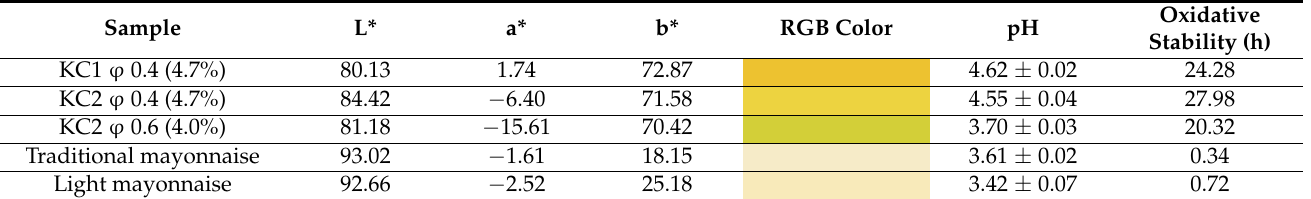
Table 4. Average values for the color parameters (L*, a* and b*) of the produced Pickering emulsions and commercial products (traditional and light